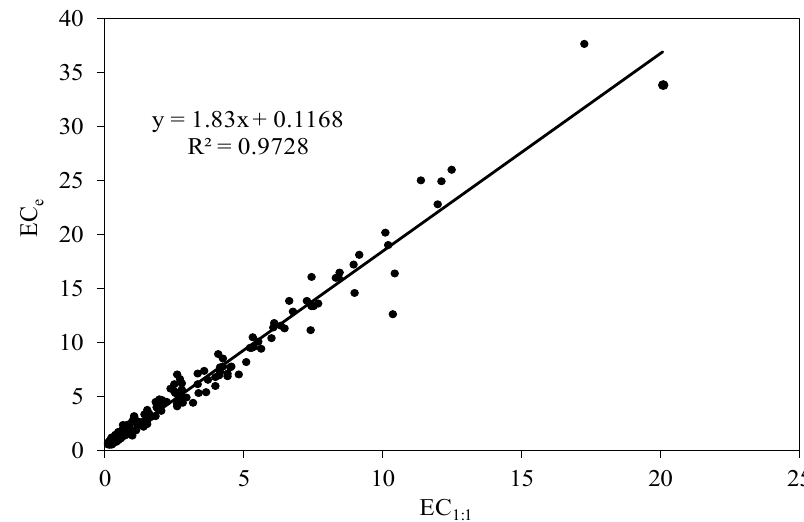
Figure 2. The EC e = f (EC 1:1 ) relationship for all soil samples collected.